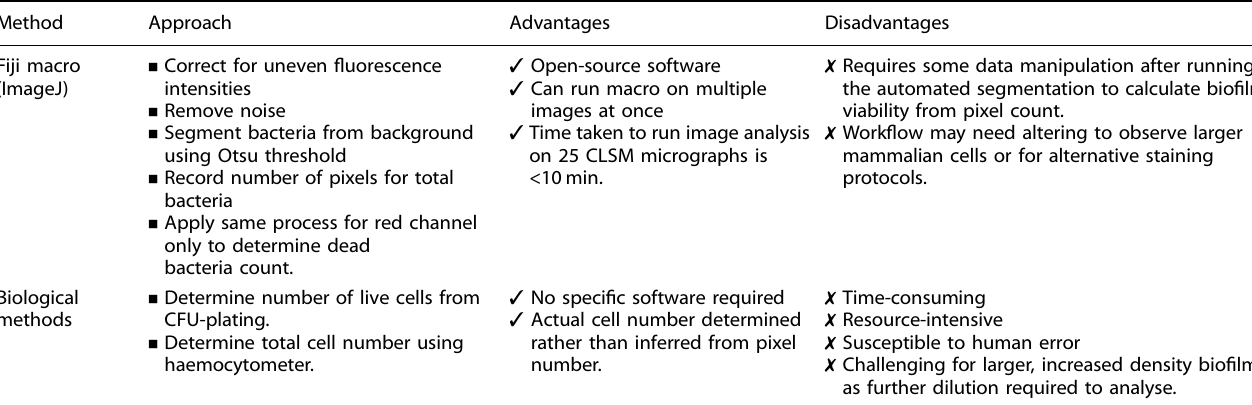
Table 1. Summary of advantages and disadvantages of image analysis and CFU-plating combined with counting cell in a haemocytometer to quantify bio fi lm